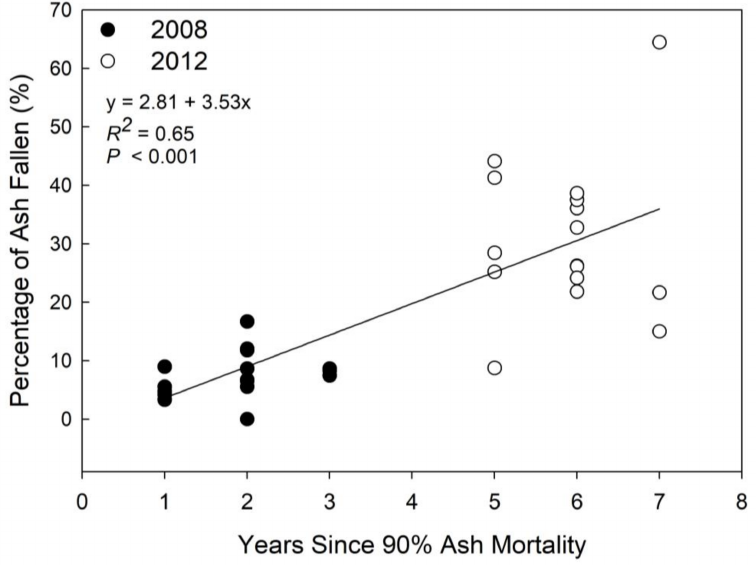
Figure 1. Relationship between the percentage of dead ash ( Fraxinus spp.) that had fallen and the number of years since the occurrence of 90% ash mortality in 16 forest stands sampled in 2008 (open circles) and in 2012 (closed circles) in the Upper Huron River watershed in southeastern Michigan, USA. Stands reached 90% ash mortality in 2006, 2007, or